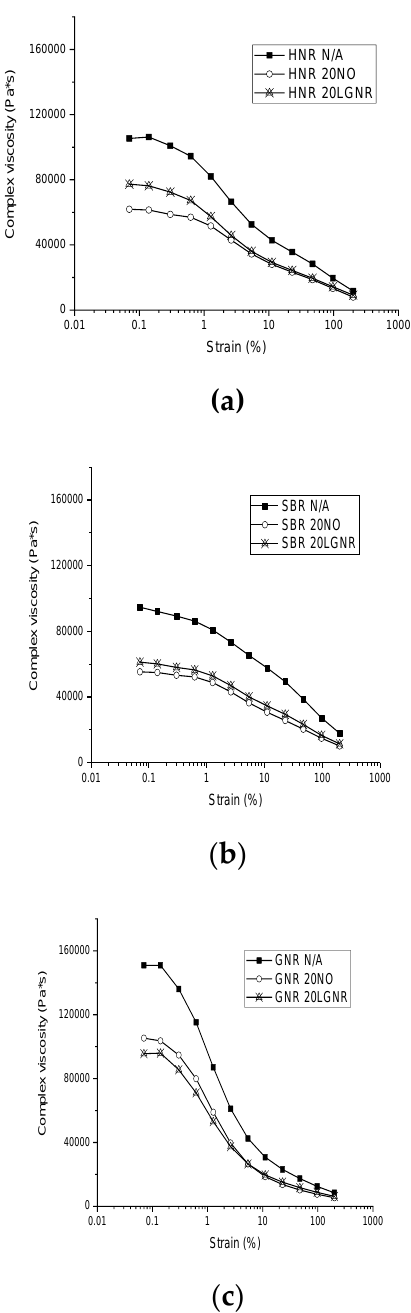
Figure 5. Complex viscosity of rubber compounds with or without processing aids from 0.07% to 200% strain amplitude: ( a ) Hevea natural rubber (HNR); ( b ) styrene butadiene rubber (SBR); ( c ) guayule natural rubber (GNR). N/A: rubber compounds without processing aids; 20 NO: rubber compounds with 20 phr naphthenic oil; 20 LGNR: rubber compounds with 20 phr liquid guayule natural rubber.